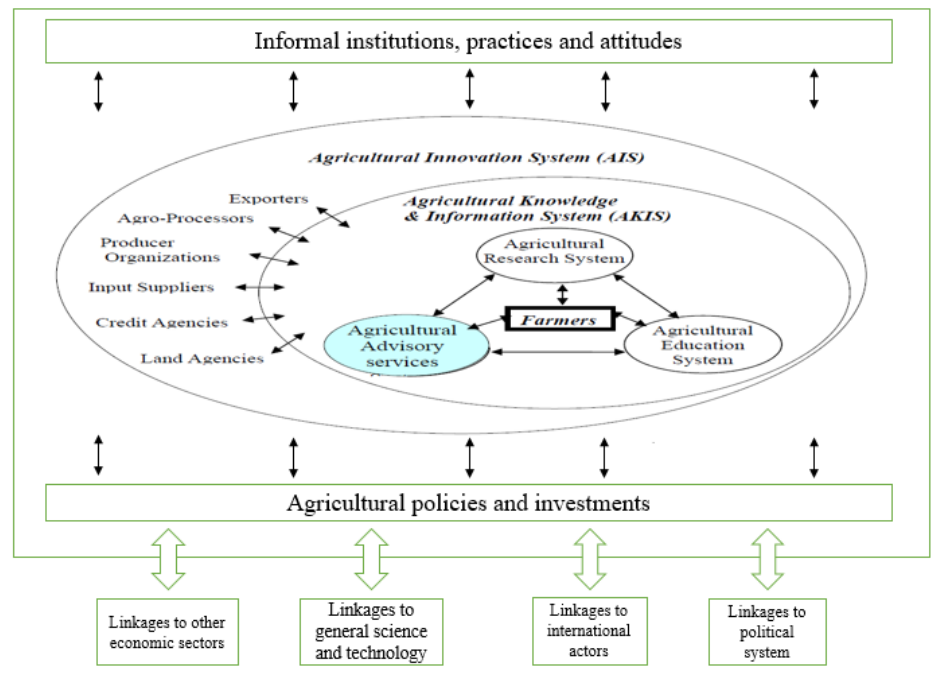
Figure 2. Agricultural advisory services as part of the agricultural innovation system (AIS). Inspired from [58], and [59] adapted from [60].